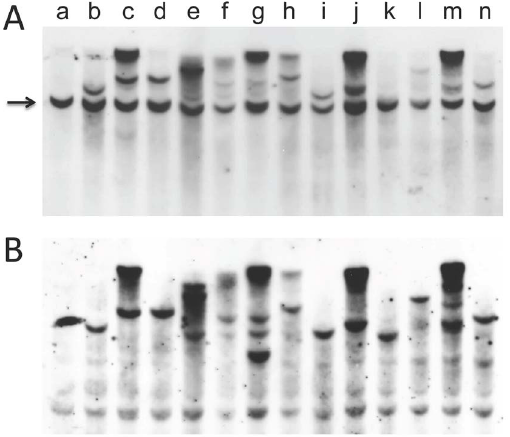
Figure 7. Analysis of the integration sites of the myc and ras genes in cell lines derived from tumors induced by linear pMSV-T24-H- ras /MSV-c- myc . DNA was isolated from tumor cell lines, digested with BsrGI , an enzyme that does not cut the plasmid, transferred to a membrane, and probed with a myc probe ( A ), or with a ras probe ( B ). Lane a is mouse NIH/3T3 DNA; lanes b to n represent different tumor cell lines. The position of the endogenous mouse c- myc gene is indicated by the arrow. [The apparent band in lane a in Fig. 7B is